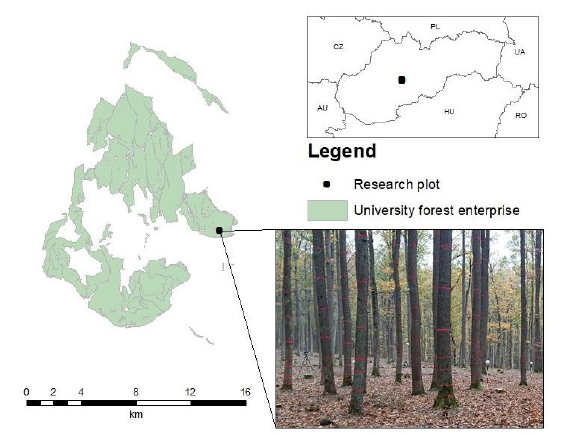
Figure 1.The study area - a managed forest located in the Central